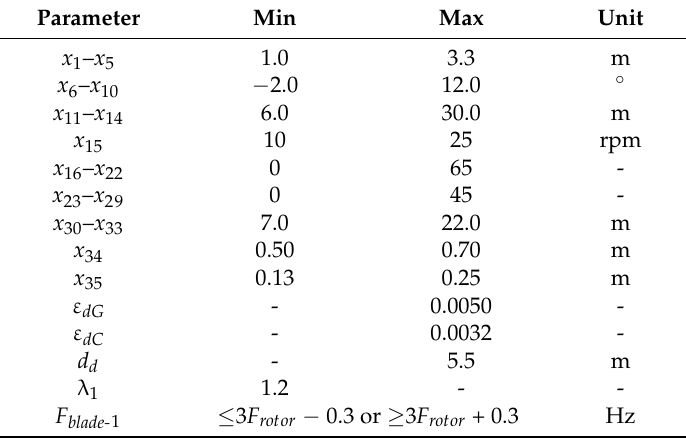
Table 4. Range of design variables and the constraint values.